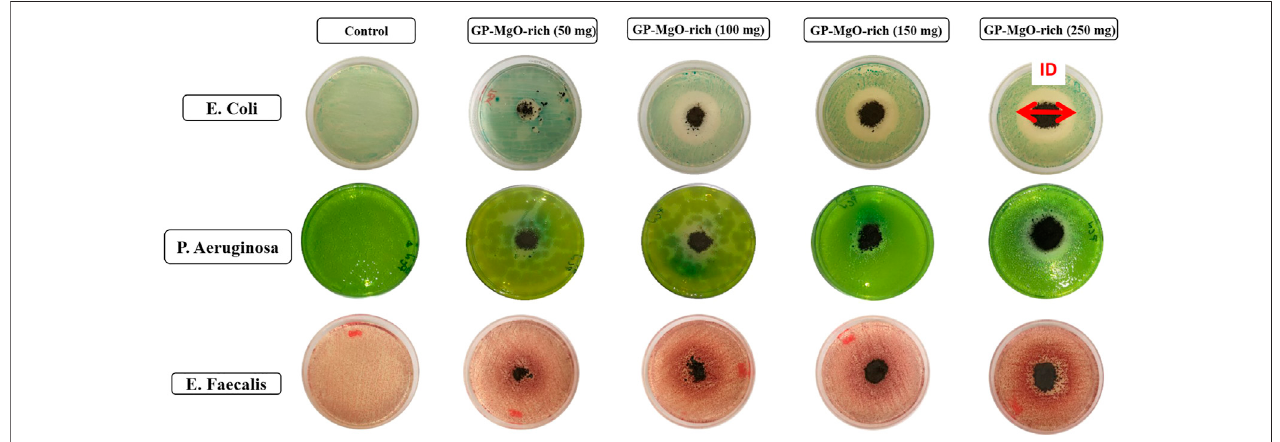
FIGURE 7 | Inhibition halo images of E. coli , P. aeruginosa , E. faecalis growing in presence of different amounts of GP-MgO-rich.